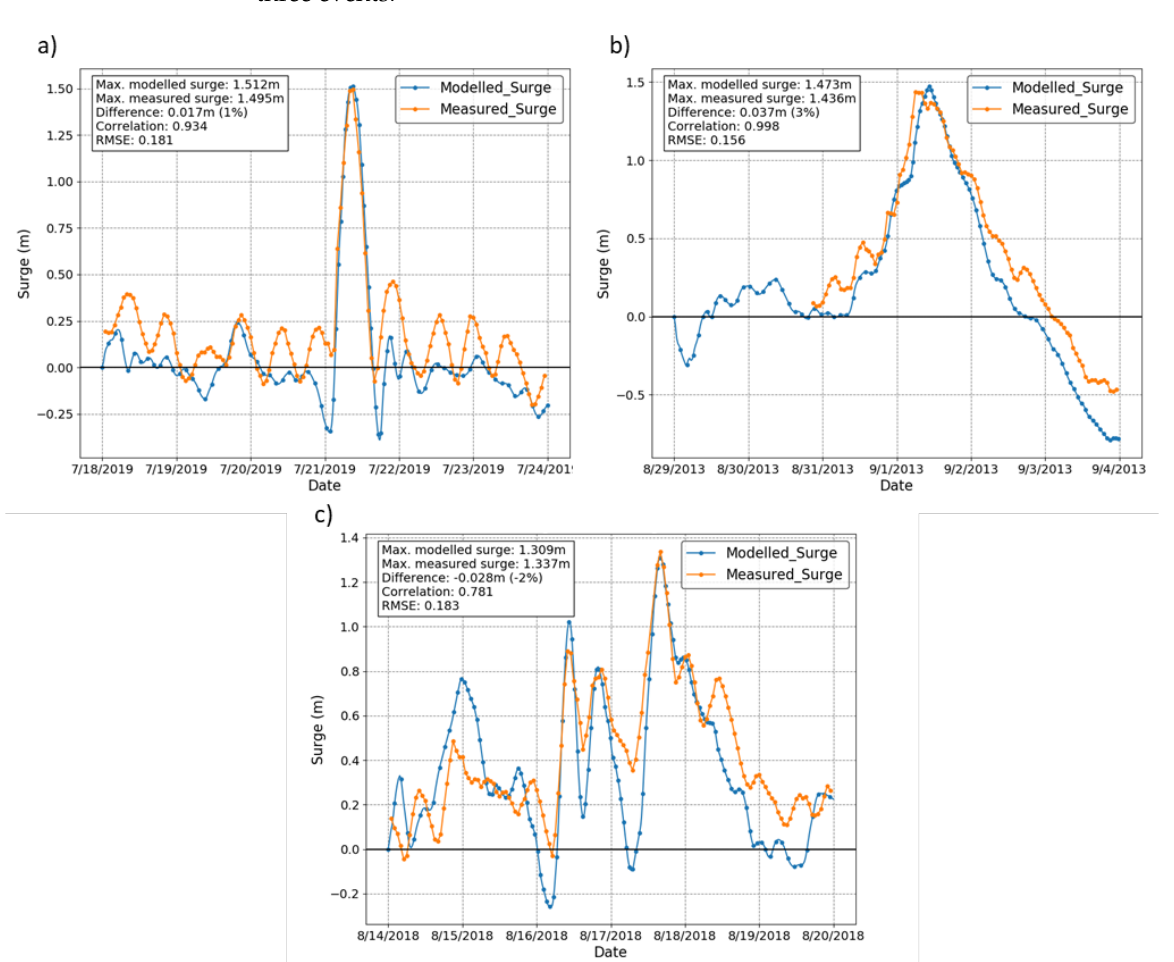
Figure 10. Results of the storm surge model calibration exercise for the storm surge events that occurred on ( a ) Event 1—July 2019; ( b ) Event 2—September 2013; ( c ) Event 4—August 2019. Results are compared to the tide gauge at Tuktoyaktuk (Station 6485). Refer to the Appendix A—Table A1 for event numbering reference.